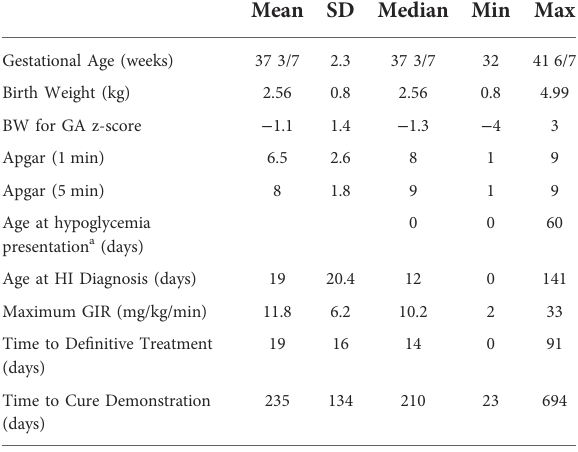
TABLE 2 Clinical characteristics ( n